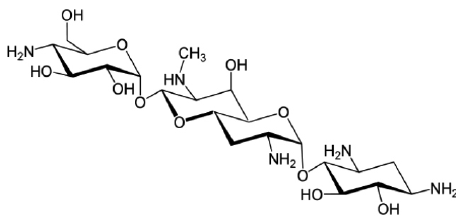
FIGURE 1 - Apramycin Chemical